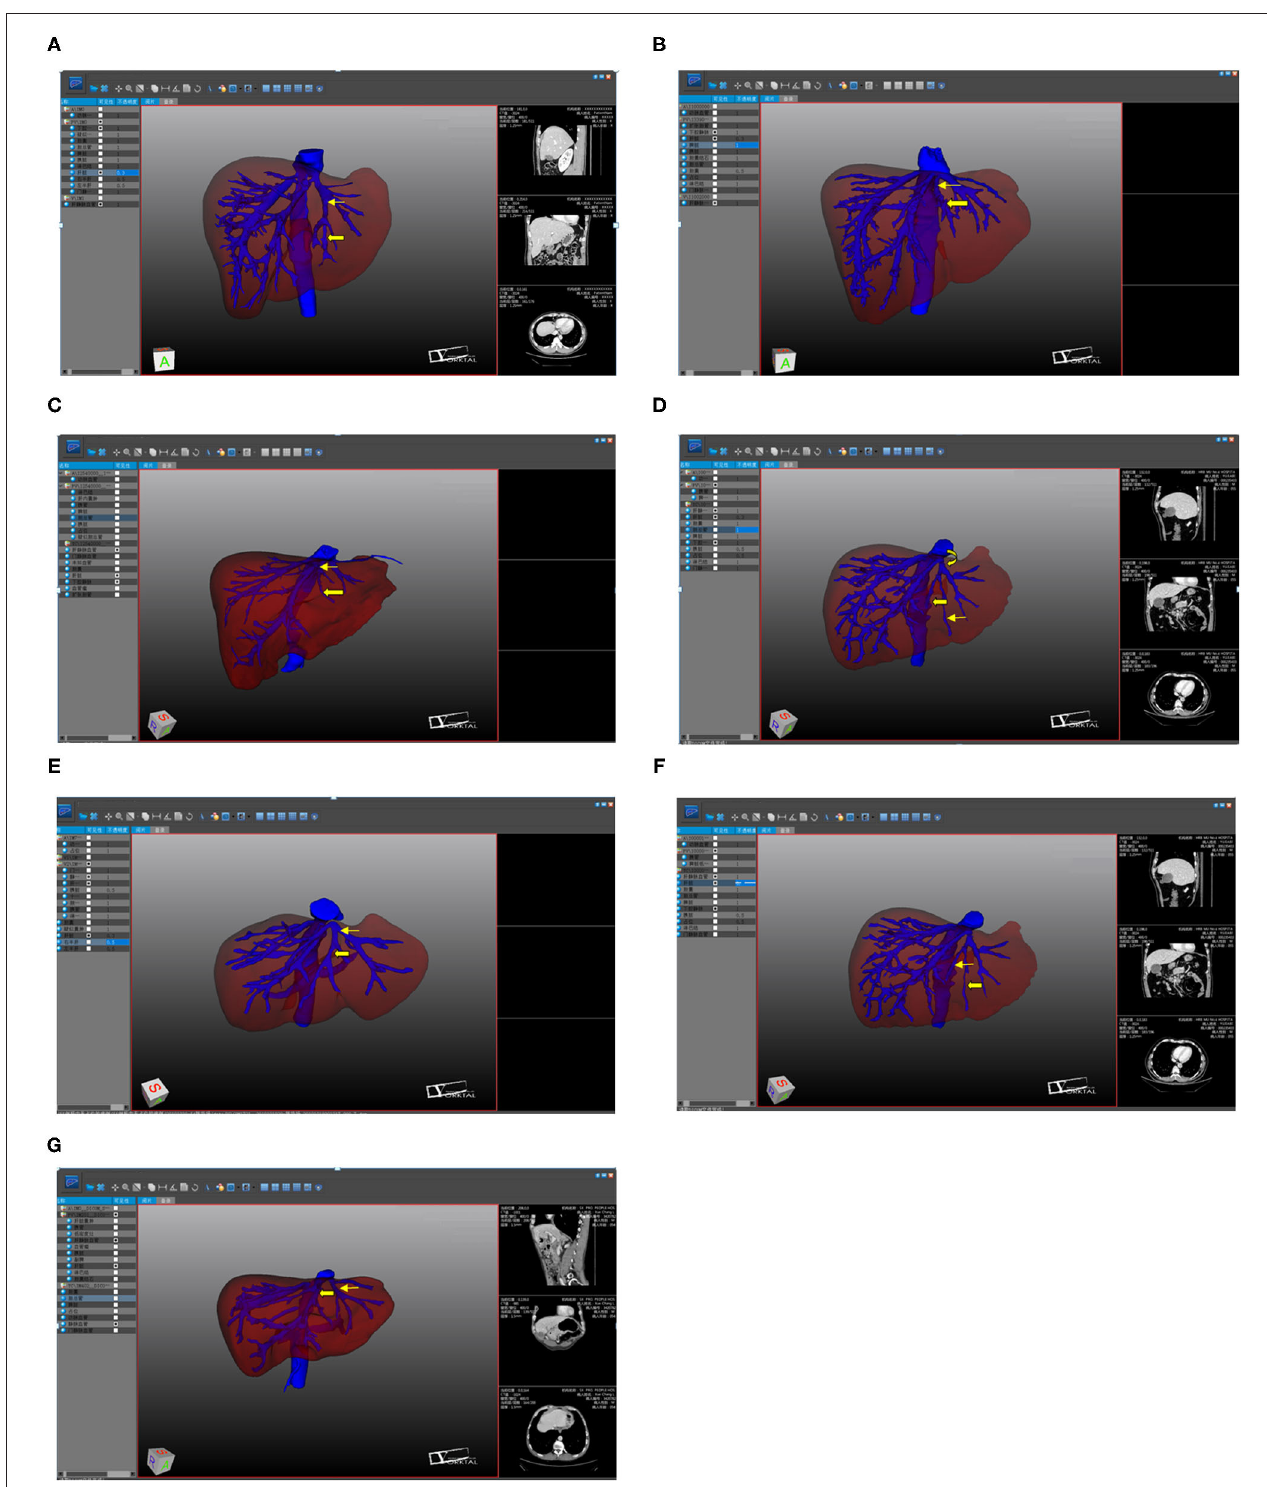
FIGURE 1 | The three-dimensional visualization. (A) UFV (Thick arrow); UFV flowing into the LHV (Thin arrow); (B) UFV (Thick arrow); UFV flowing into the confluence part of the LHV and the MHV (Thin arrow); (C) UFV (Thick arrow); UFV flowing into the MHV (Thin arrow); (D) accessory S4 hepatic vein (Thick arrow); UFV (Thin arrow); accessory S4 liver vein flowing into the LHV; (E) accessory S4 hepatic vein (Thick arrow); UFV (Thin arrow); accessory S4 hepatic vein flowing into the confluence part of the LHV and the MHV; (F) UFV (Thick arrow); accessory S4 hepatic vein (Thin arrow); (G) MHV (Thick arrow); LHV (Thin arrow).